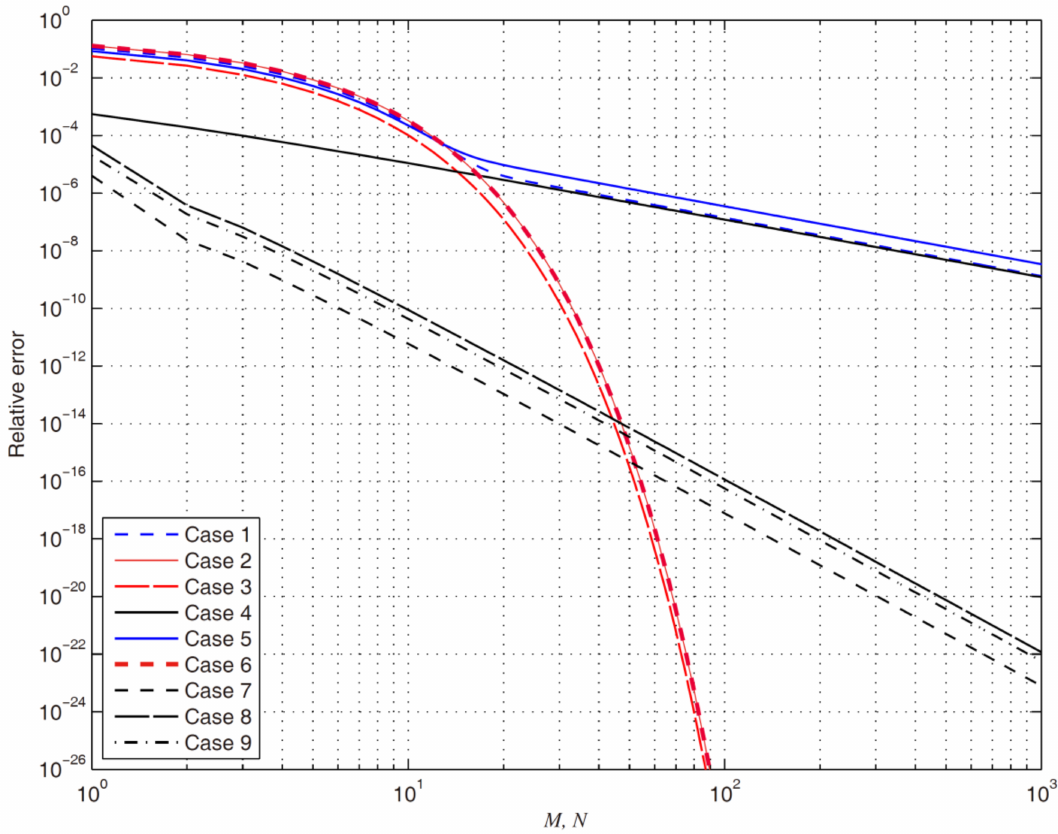
Figure 6. Convergence processes of inter-well pressure difference for the nine cases, with Euler transform being invoked for Cases 1, 2, 3, 5, and